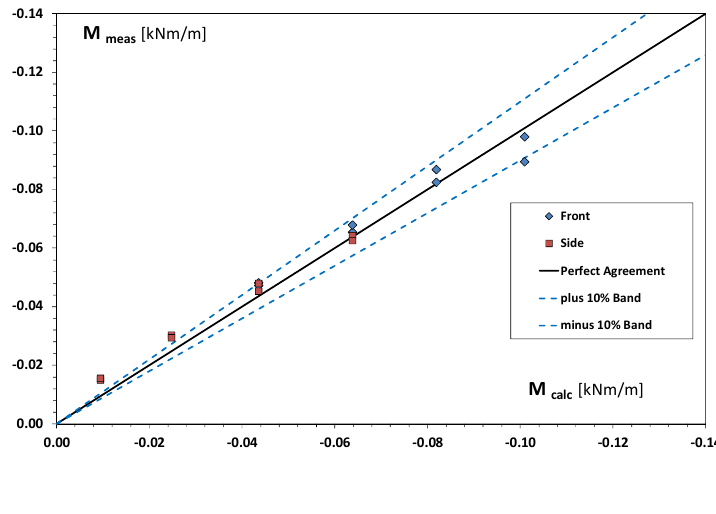
Figure 19. Measured vs. predicted overturning